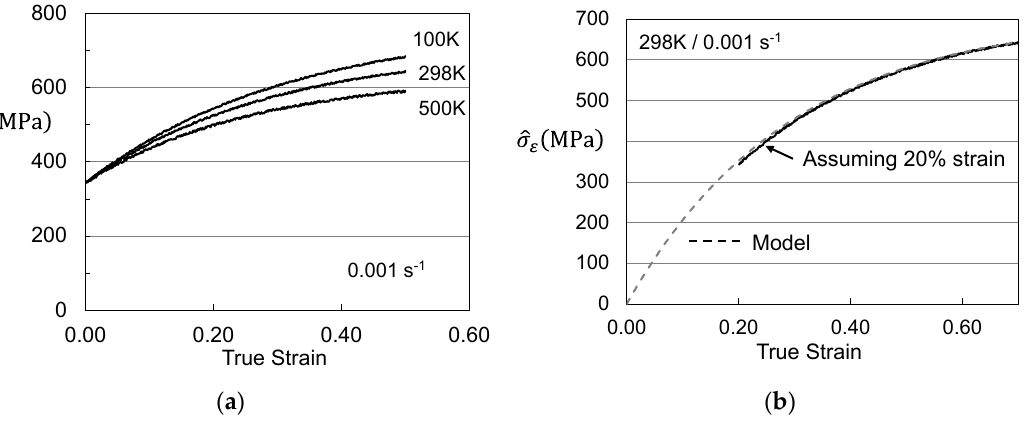
Figure 9. Assessed evolution for the hot worked material. ( a ) ˆ σ ε versus strain according to Equation (4); ( b ) Evolution according to model versus that assuming an initial strain of 20%.